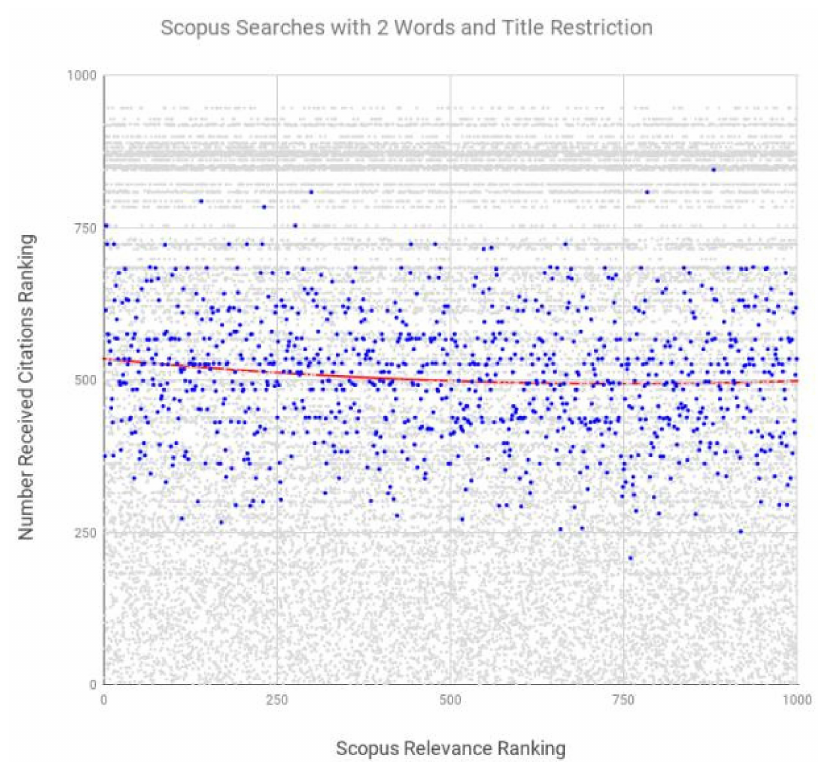
Figure 8. Scopus Searches with Two Words and Title Restriction (rho − 0.10, median in blue, the rest of data in gray).